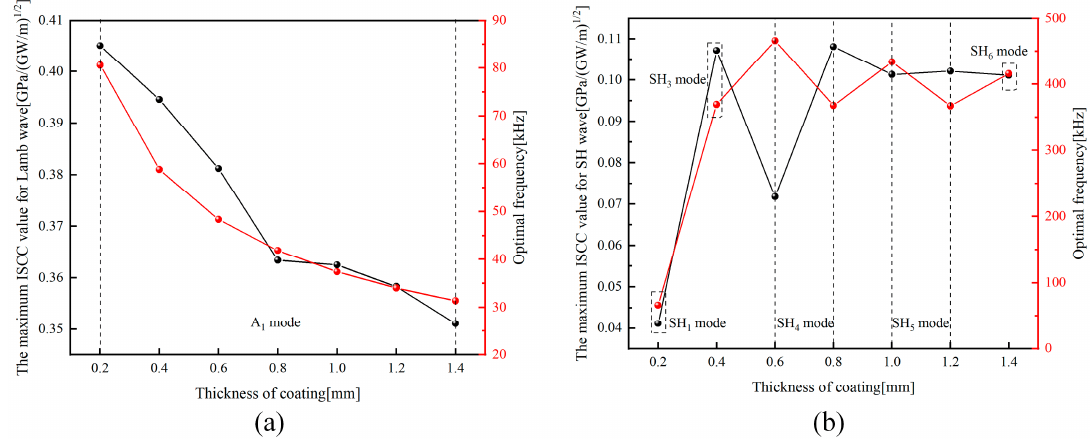
Figure 7. The effects of coating thickness on maximum ISCC value and optimal frequency: ( a ) Lamb waves; ( b ) SH waves.